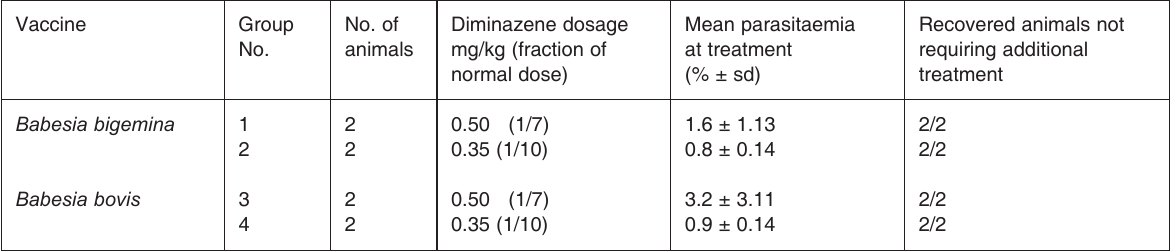
reactions in splenectomized